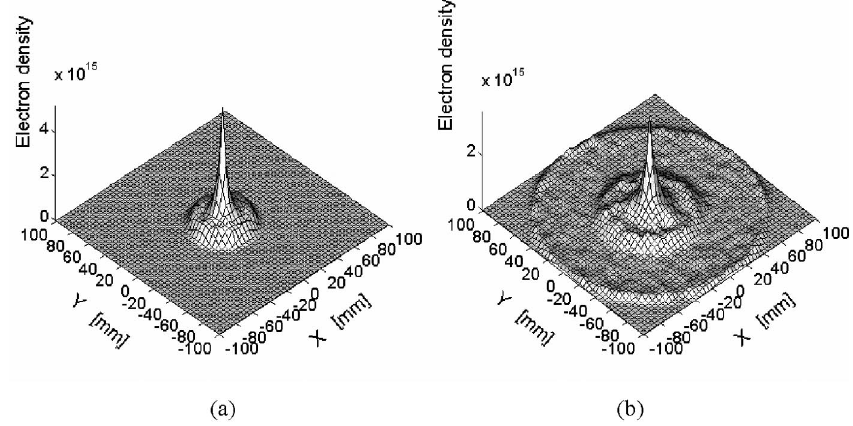
FIG. 8. Electron distribution in the transverse plane at (a) 350 ns and (b) 630 ns with zero clearing